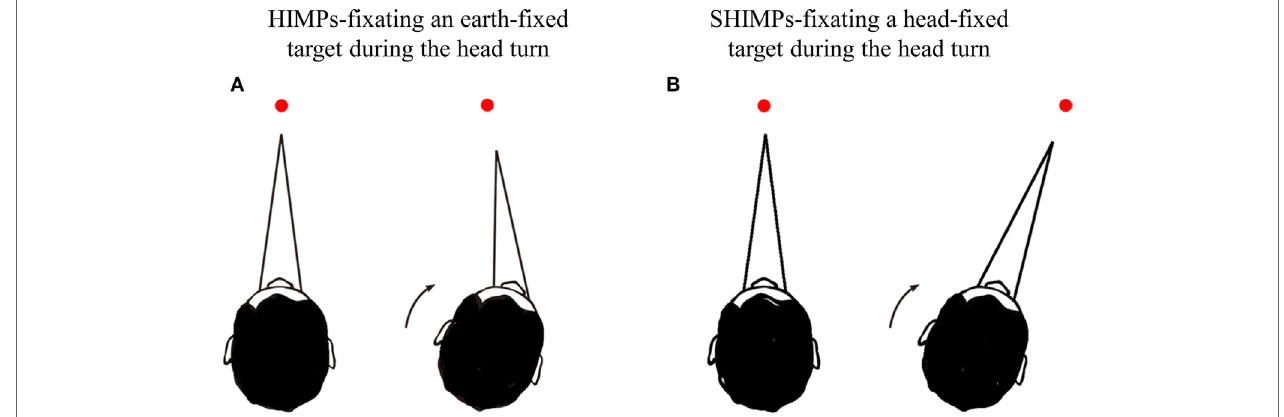
FigUre 1 | Schematic diagram showing the procedures for head impulse test (HIMP) and SHIMP tests. (a) In HIMPs, subjects were instructed to fixate on an earth-fixed laser dot on the wall at 90 cm distance in front of the patient. The clinician applied 20 horizontal head impulses to each side with unpredictable timing and direction. (B) In SHIMPs, patients were instructed to fixate a laser spot target projected on the wall at 90 cm distance in front of them from a head-mounted laser. This spot moved with the head and subjects were instructed to stare at the spot. Ten serial impulses were delivered to left and right side,